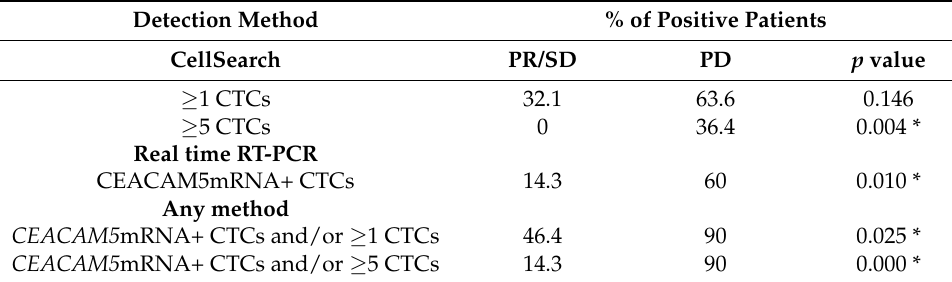
Table 3. CTC detection using different assays according to best response to first-line chemotherapy.